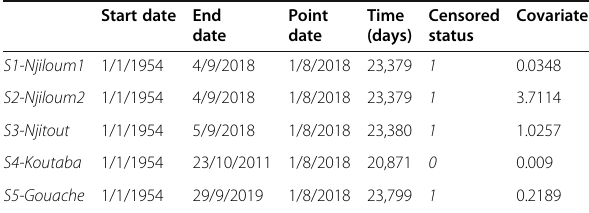
Table 11 Summary